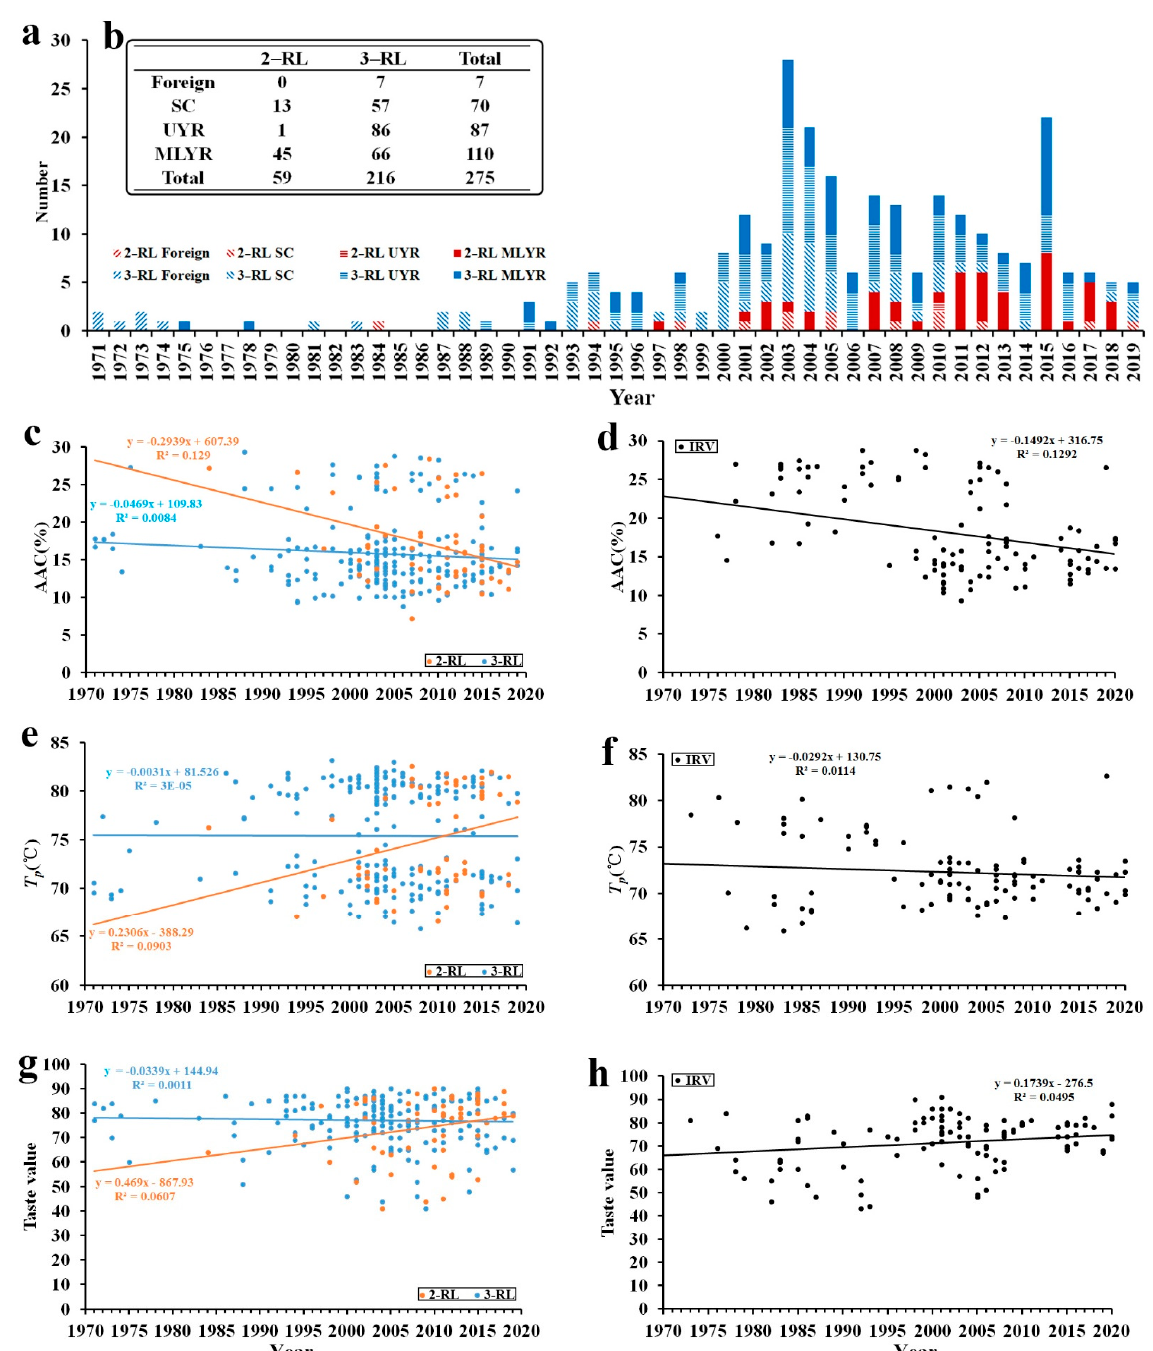
Figure 1. Phenotypic distribution statistics over time. ( a , b ) Distributions of materials in terms of breeding time, region and type. ( c , e , g ) 2-RLs and 3-RLs. ( d , f , h ) IRVs. ( c , d ) Apparent amylose content. ( e , f ) Peak temperature of gelatinisation. ( g , h ) Taste value.